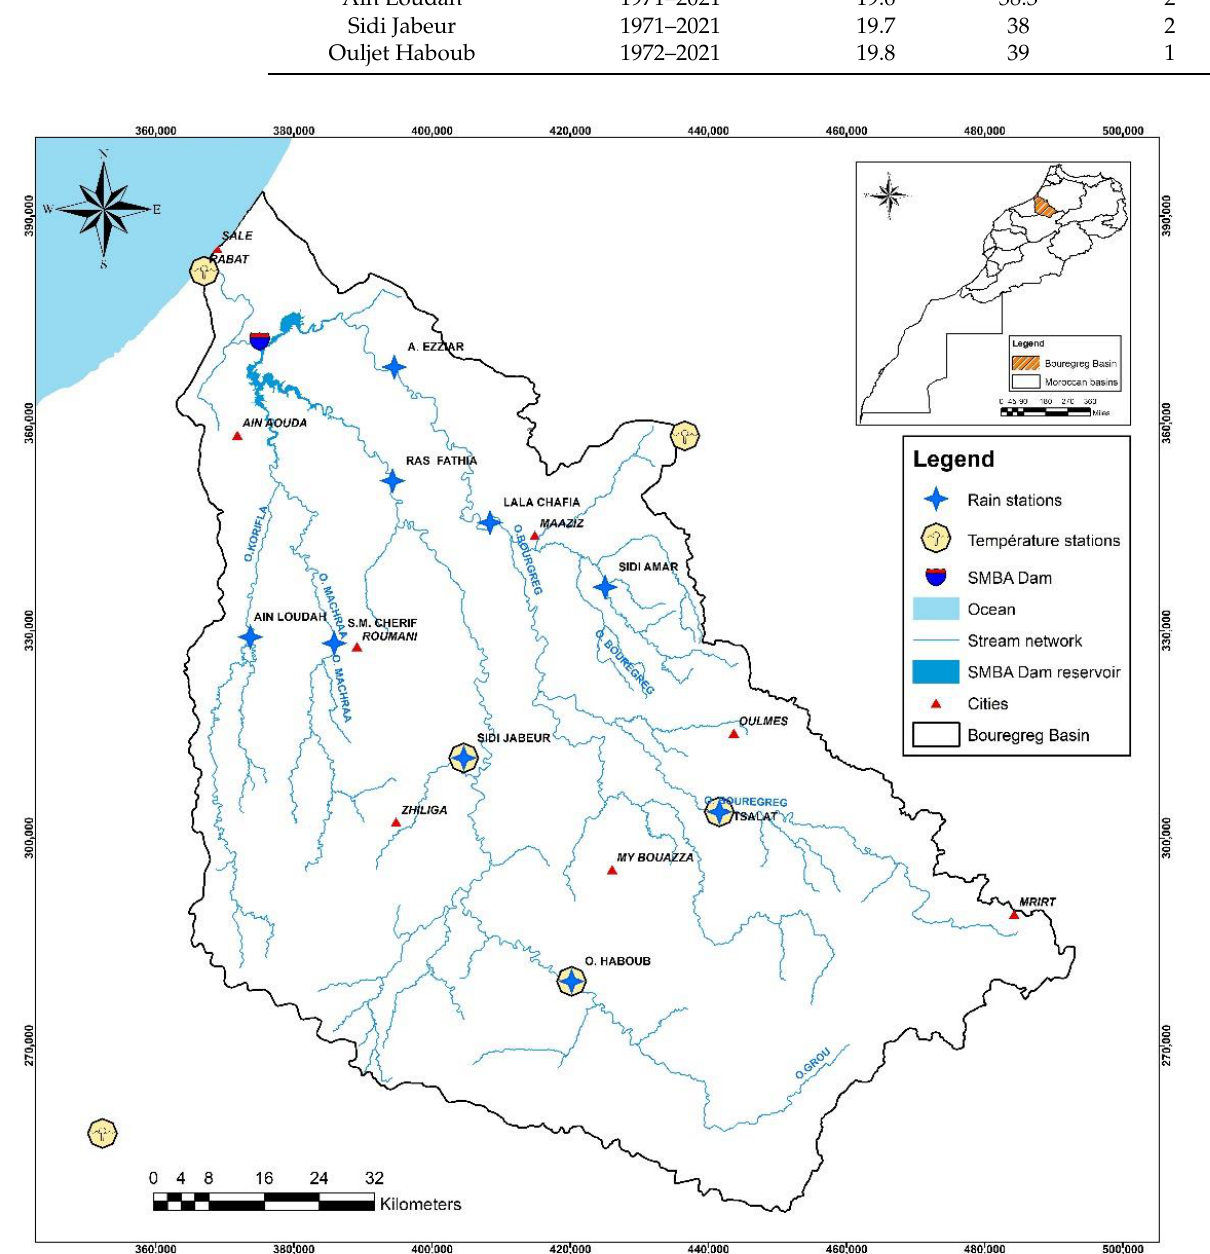
Figure 1. Bouregreg Basin location, in Morocco. Table 2. Statistical characteristics of the monthly precipitation data recorded at nine monitoring rainfall stations.